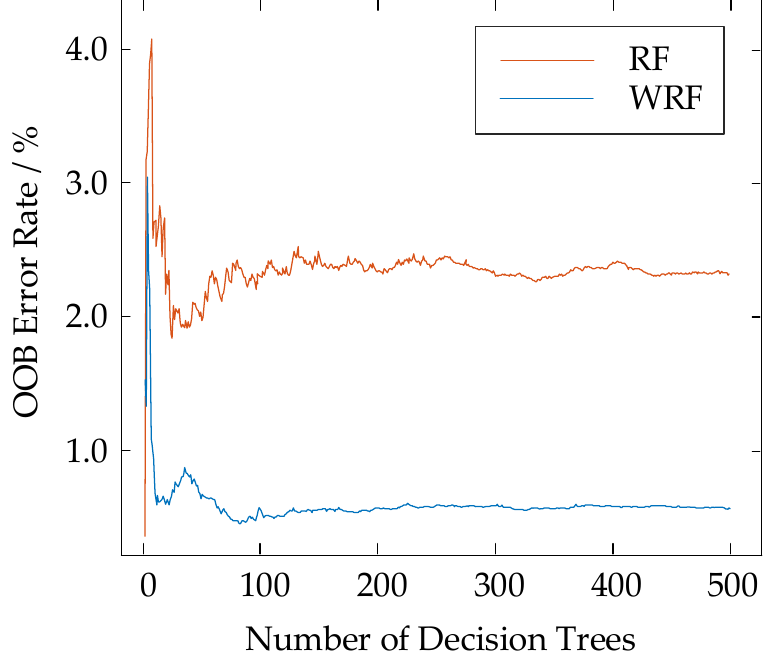
Figure 7. OOB error of random forest algorithm.